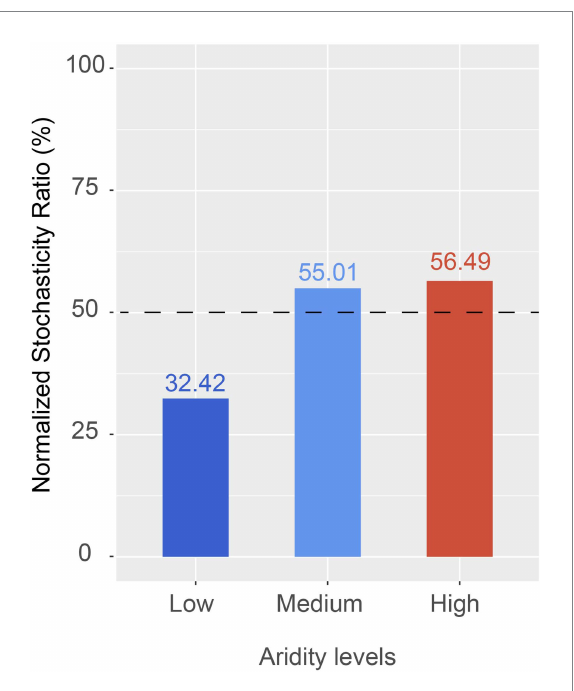
FIGURE 7 The normalized stochasticity ratio (NST) of soil pqqC community in different aridity